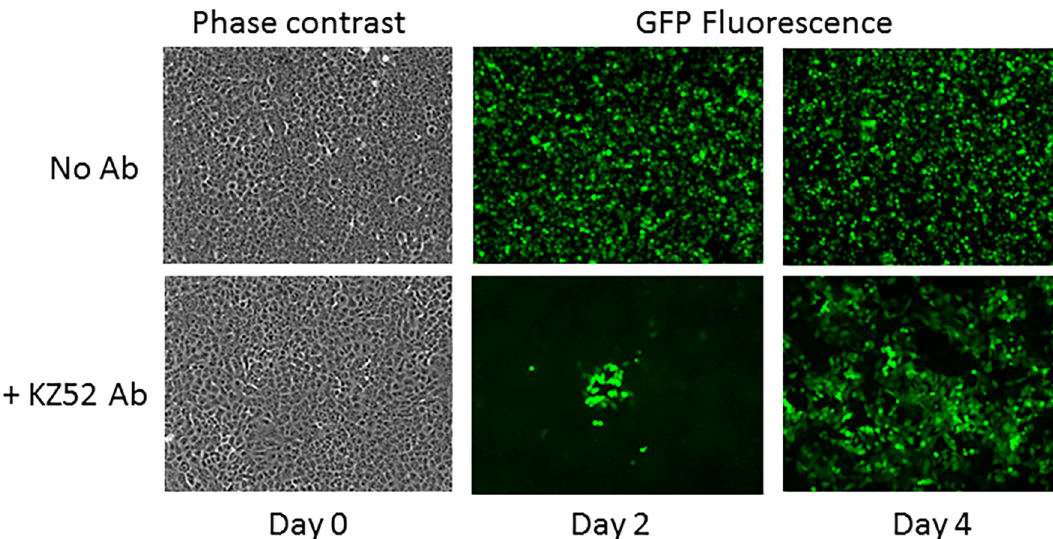
Fig 4. Micrographs of cells infected with rVSV-EBOVgp-GFP recombinant virus. Vero E6 cells are pictured on successive days in passage two. The top panel was cultured in the absence of antibody. The bottom panel was cultured in the presence of monoclonal antibody KZ52 which neutralizes virus infection. Day 0, initial infection, is shown in phase contrast to reveal the confluent Vero E6 cells. Over time, escape mutants arise as indicated by the numerous infected cells in the presence of KZ52 on day 4. Expression of GFP indicating virus replication was visualized under the fluorescent microscope at 100X magnification on day 2 and day 4.